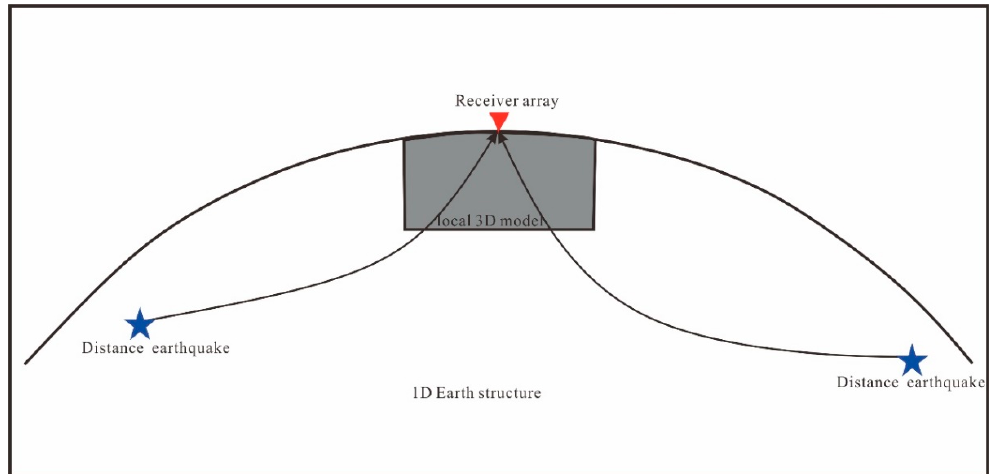
Figure 5. The principle of the teleseismic tomography. The red triangular denotes the receiver array. The blue stars denote the distance earthquake [45].